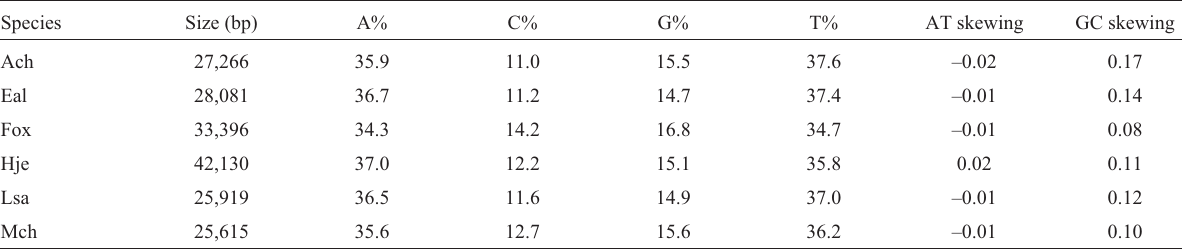
Table 3 - Composition and skewing in the mitochondrial genomes of Hypocreales. Species